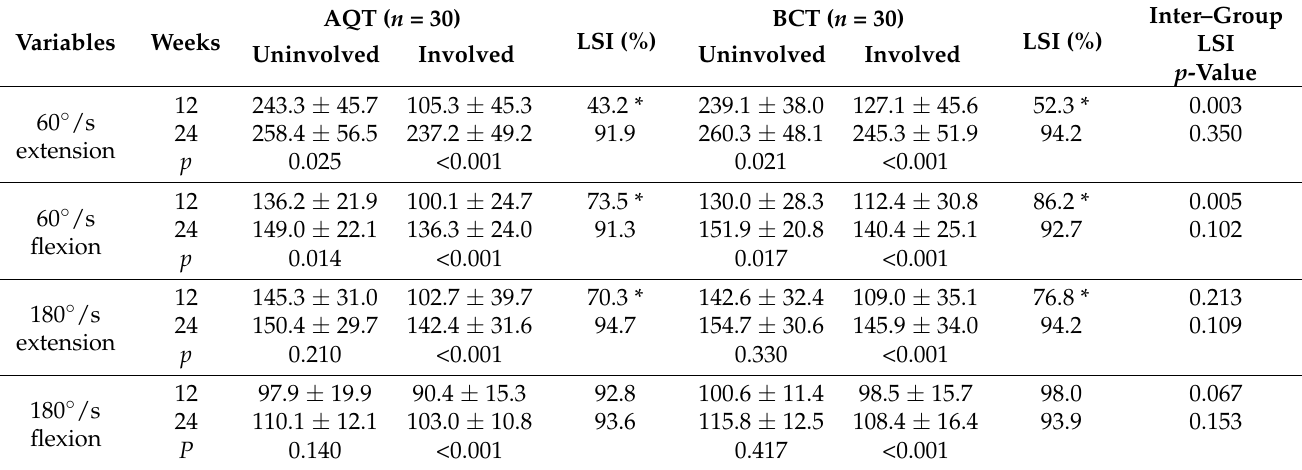
Table 5. Isokinetic knee strength according to group and weeks.